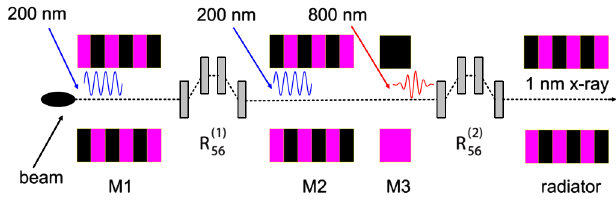
FIG. 1. (Color) Schematic of the proposed scheme for genera- tion of isolated attosecond x-ray